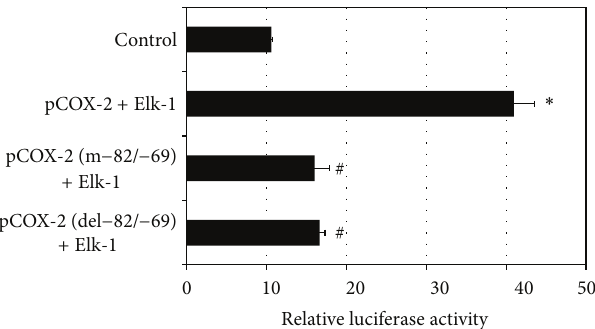
Figure 4: Elk-1 upregulated COX-2 promoter activity through Elk-1 binding site. The Elk-1 expression vector (pCMV3.0b-Elk- 1) or control vector (pCMV3.0b) was transfected together with construct pCOX-2 ( − 2026/+44), pCOX-2 ( − 2026/+44, m − 82/ − 69), or pCOX-2 ( − 2026/+44, del − 82/ − 69). Relative luciferase activity was expressed as mean ± SEM and represented three different experiments in triplicate for each fragment. ∗ 𝑃 < 0.001 versus control. # 𝑃 < 0.001 versus pCOX-2 ( − 2026/+44) transfacted with pCMV3.0b- Elk-1.